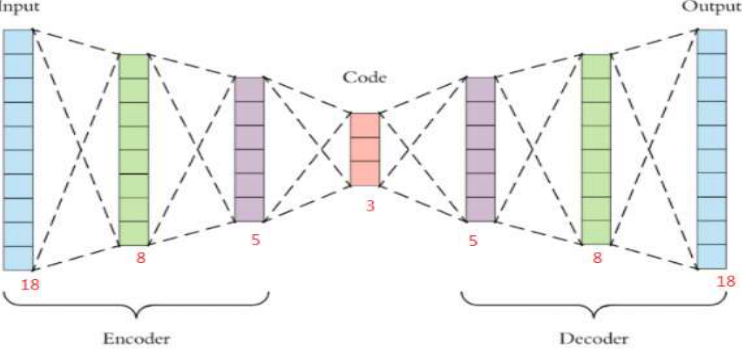
Figure 5. The architecture of our AE model.